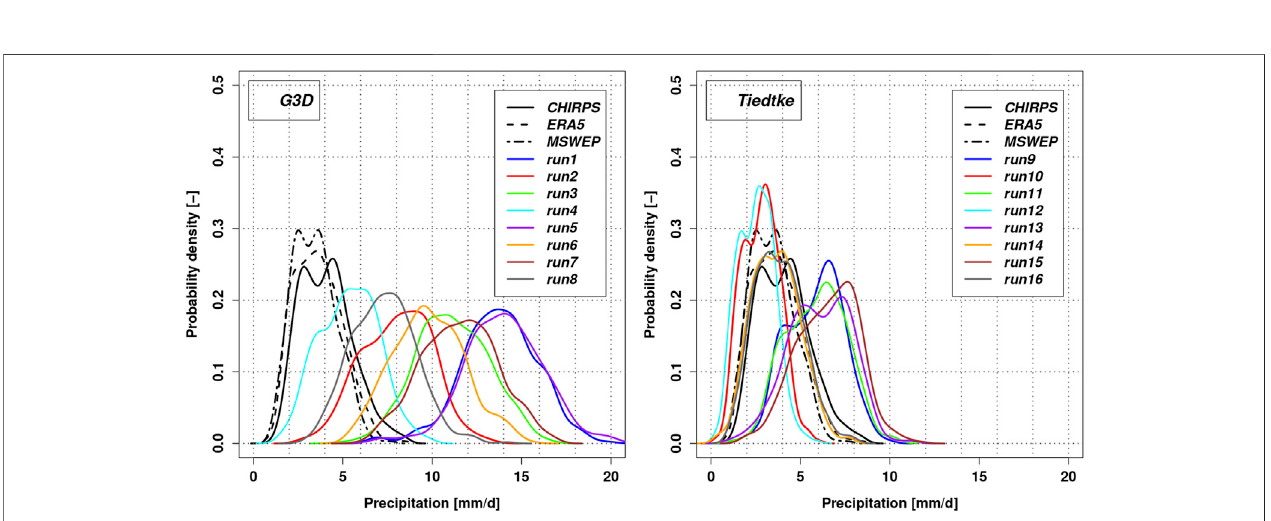
FIGURE 4| Probability Density Function (PDF) of simulated (JJA) daily mean precipitation in the WRF runs using G3D (left) and Tiedtke convection scheme (right) for domain 2 (2006 – 2010). CHIRPS, ERA5-Land, and MSWEP are given as reference precipitation.